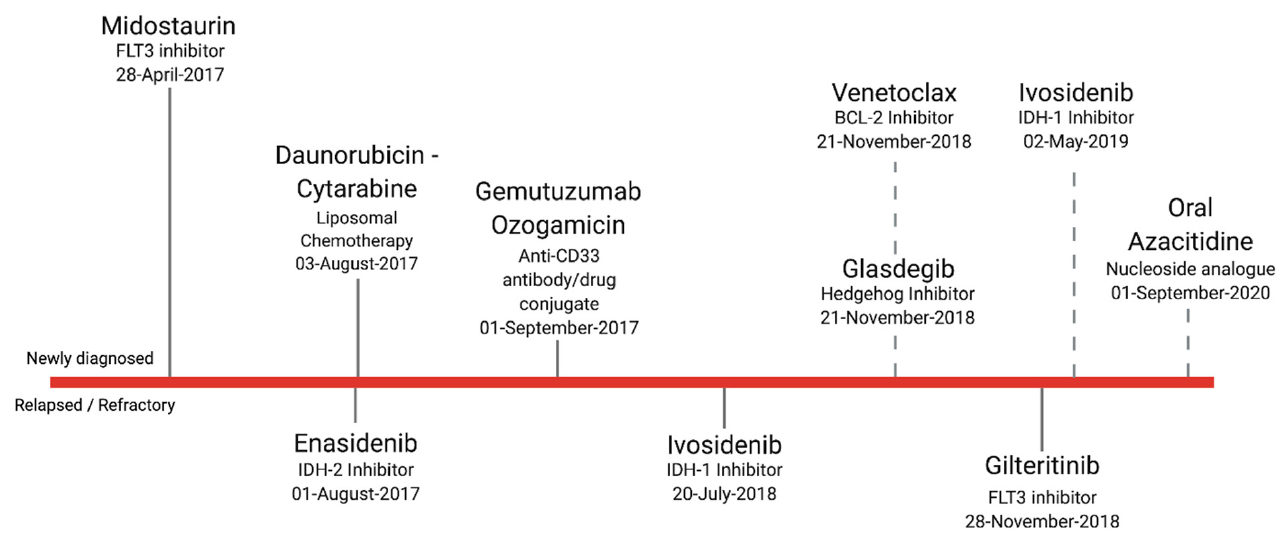
Figure 1. Timeline of recent U.S. FDA drug approvals for acute myeloid leukemia. Agents listed above the red bar indicate agents approved for use in the newly diagnosed setting. Those below the bar indicate approval for patients with relapsed/refractory disease. Agents with a dashed line were approved for patients felt to be ineligible for intensive treatment strategies. Of note, gemtuzumab ozogamicin is traditionally used as an adjunct to standard induction therapy but may be used as a single agent. It also carries approval for the relapsed/refractory setting but is almost always employed as part of induction for de novo disease. Lastly, oral azacytidine, the most recent addition to AML treatment options, is indicated for maintenance therapy.